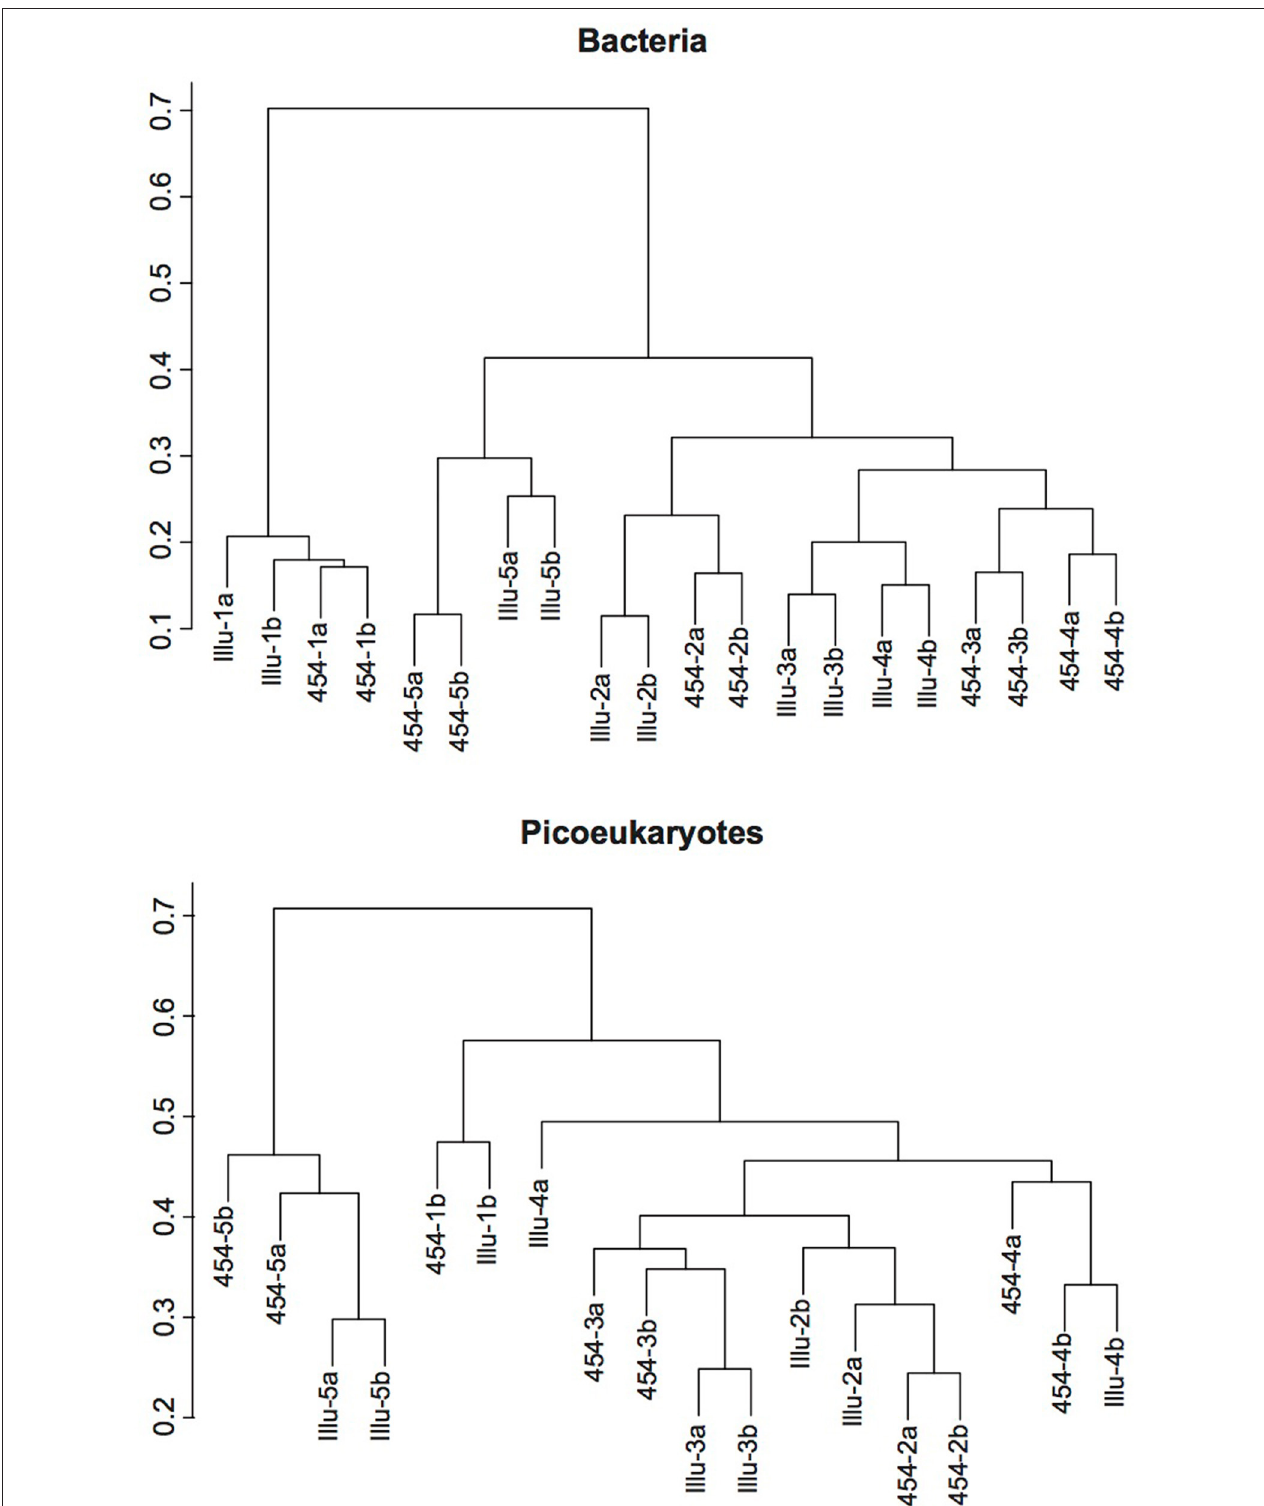
FIGURE 5 | Hierarchical clustering dendograms representing Bray-Curtis dissimilarities for the bacterial (top) and picoeukaryotic (bottom) samples. The samples are coded with the platform used (Illu for Illumina, and 454 for 454-pyrosequencing), the station number (from 1, the coastal station, to 5, the offshore one), and the replicate (a,